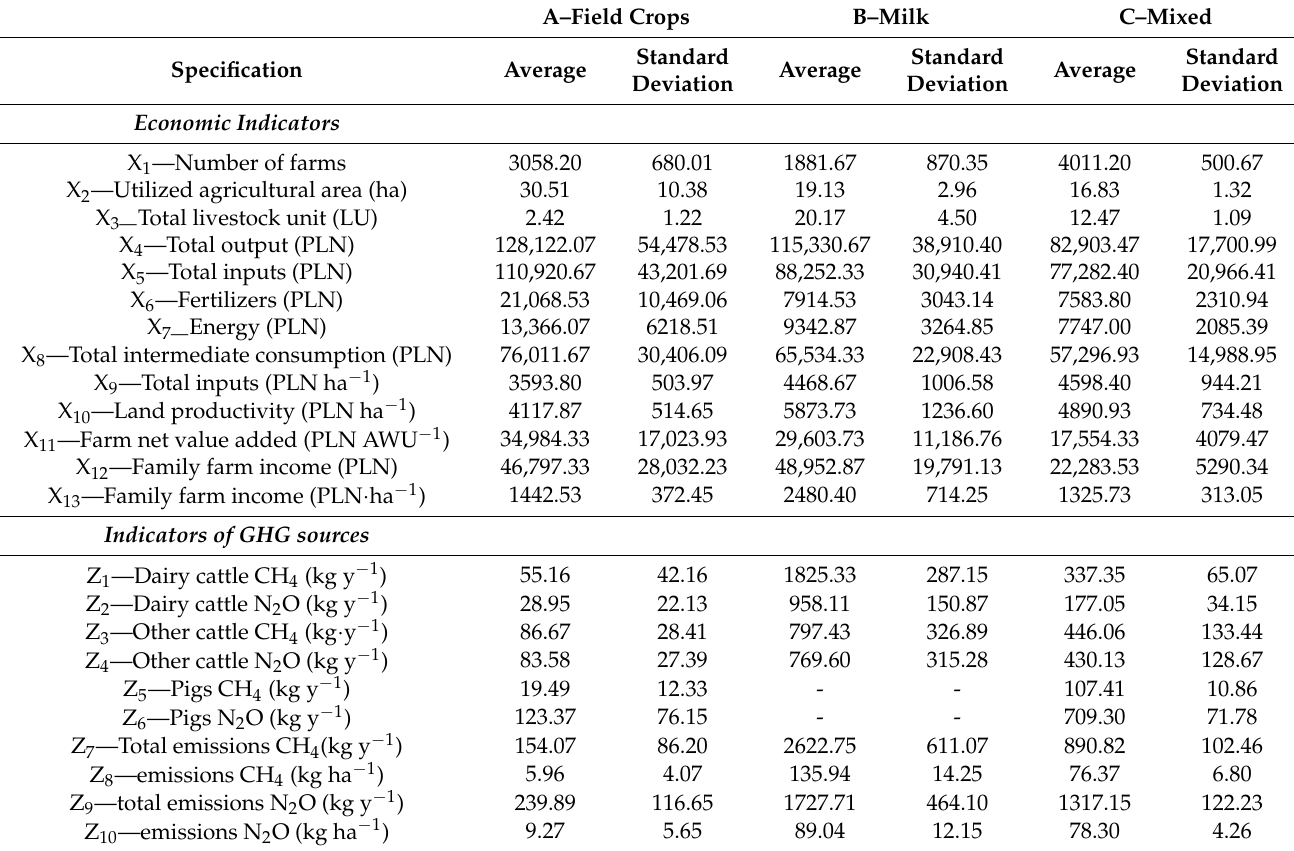
Table 1. Values of variables used in the analysis (for three types of